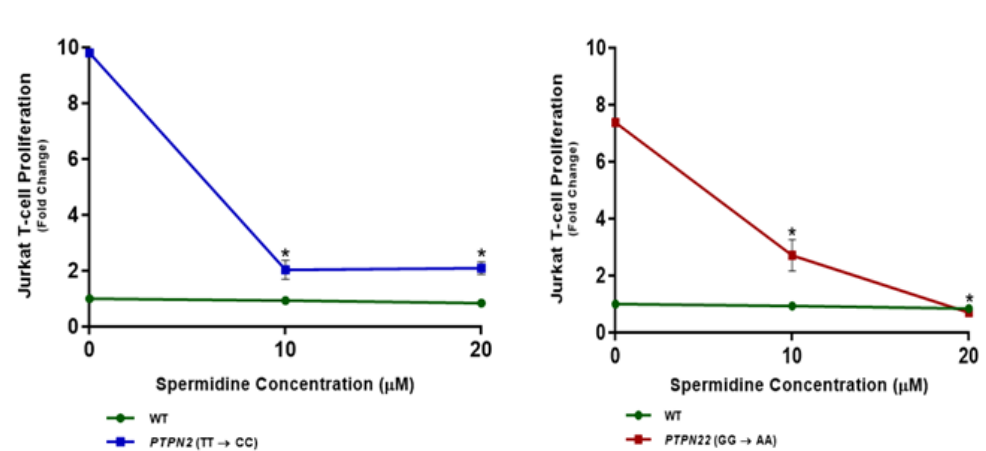
Figure 7. Effect of Spermidine on Proliferation in CRISPR-Cas9-edited Jurkat T-cells Stimulated with PHA. BrdU-labeling proliferation ELISA was used to measure proliferation in ( A , B ) WT, ( A ) PTPN2 SNP, and ( B ) PTPN22 SNP Jurkat T-cells stimulated with PHA (10 μ g/mL) and treated with spermidine (0, 10, 20 μ M) ( n = 3). * p < 0.05.